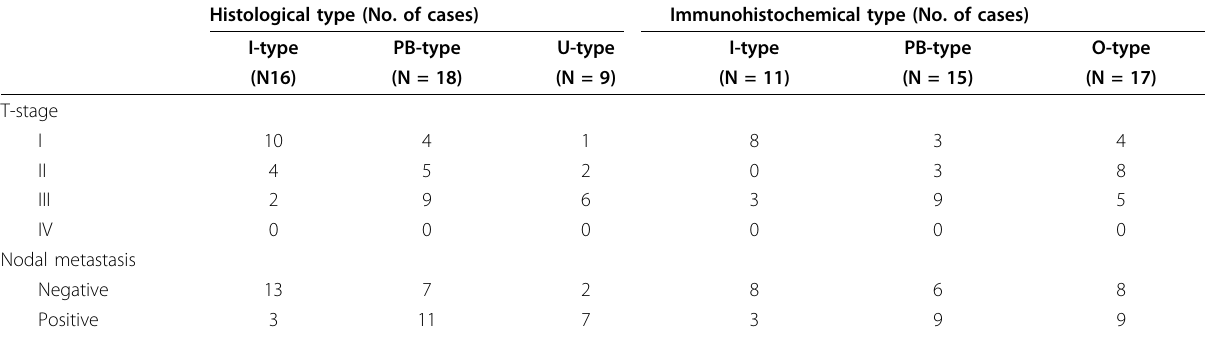
Table 5 Correlations of Tumor Parameters with Both Histological and Immunohistochemical Classifications Histological type (No. of cases)